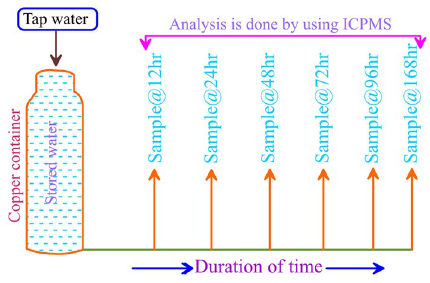
Fig. 1 Pictorial form of methodology (Raw water, stored water, sam- ples collection, analysis)